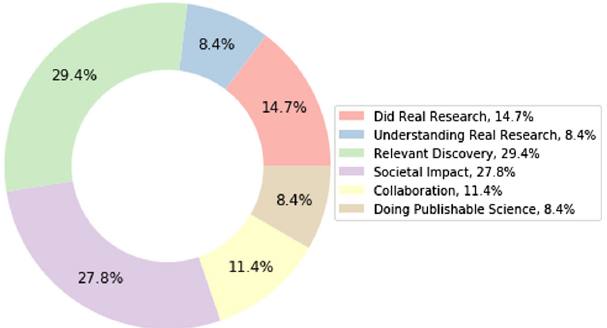
FIG. 6. Percentage of times that scientific practices was co- coded with each other indirect and direct authenticity code.